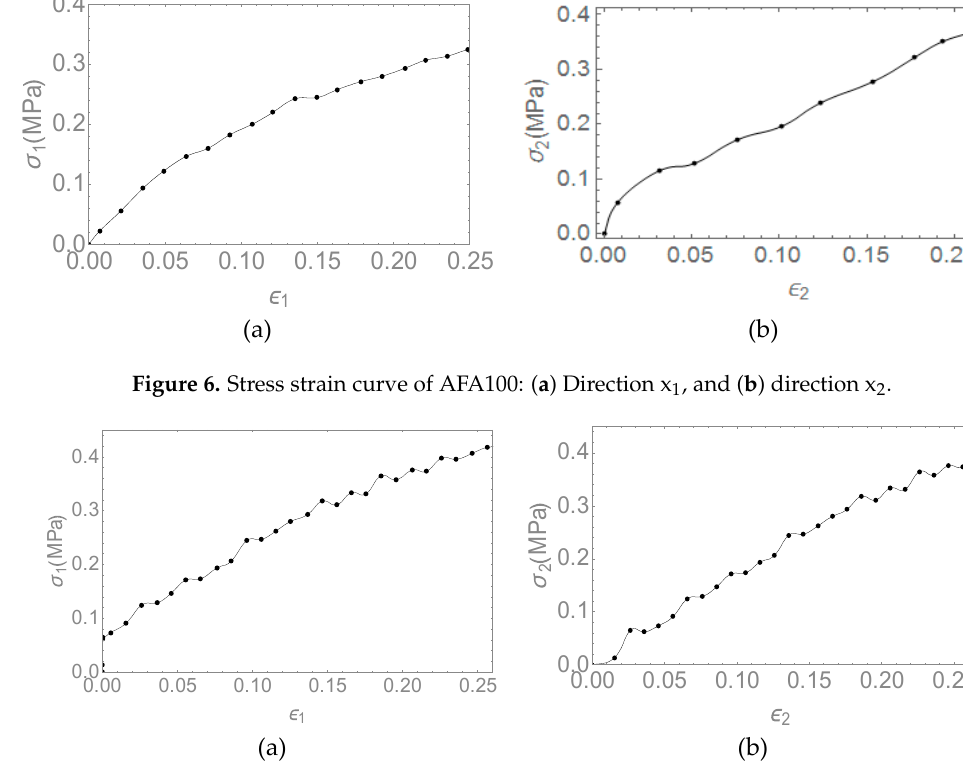
Table 3. Mean value (±SD) of mechanical parameters with biaxial tests on AFA films.